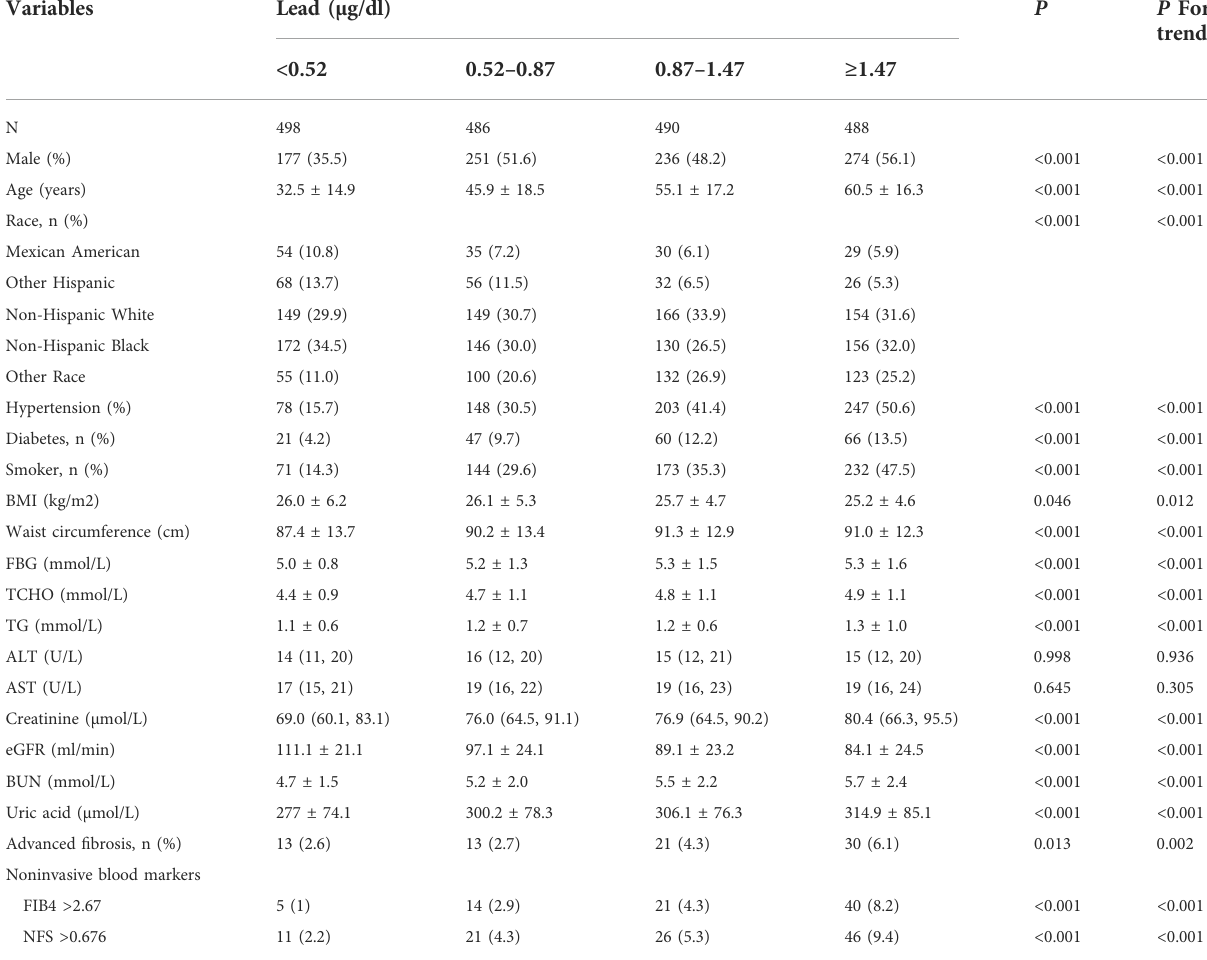
TABLE 2 Baseline characteristics of individuals with different blood lead level (quartiles 1 –